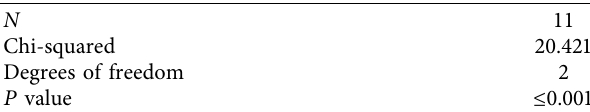
Table 2: Friedman test result.